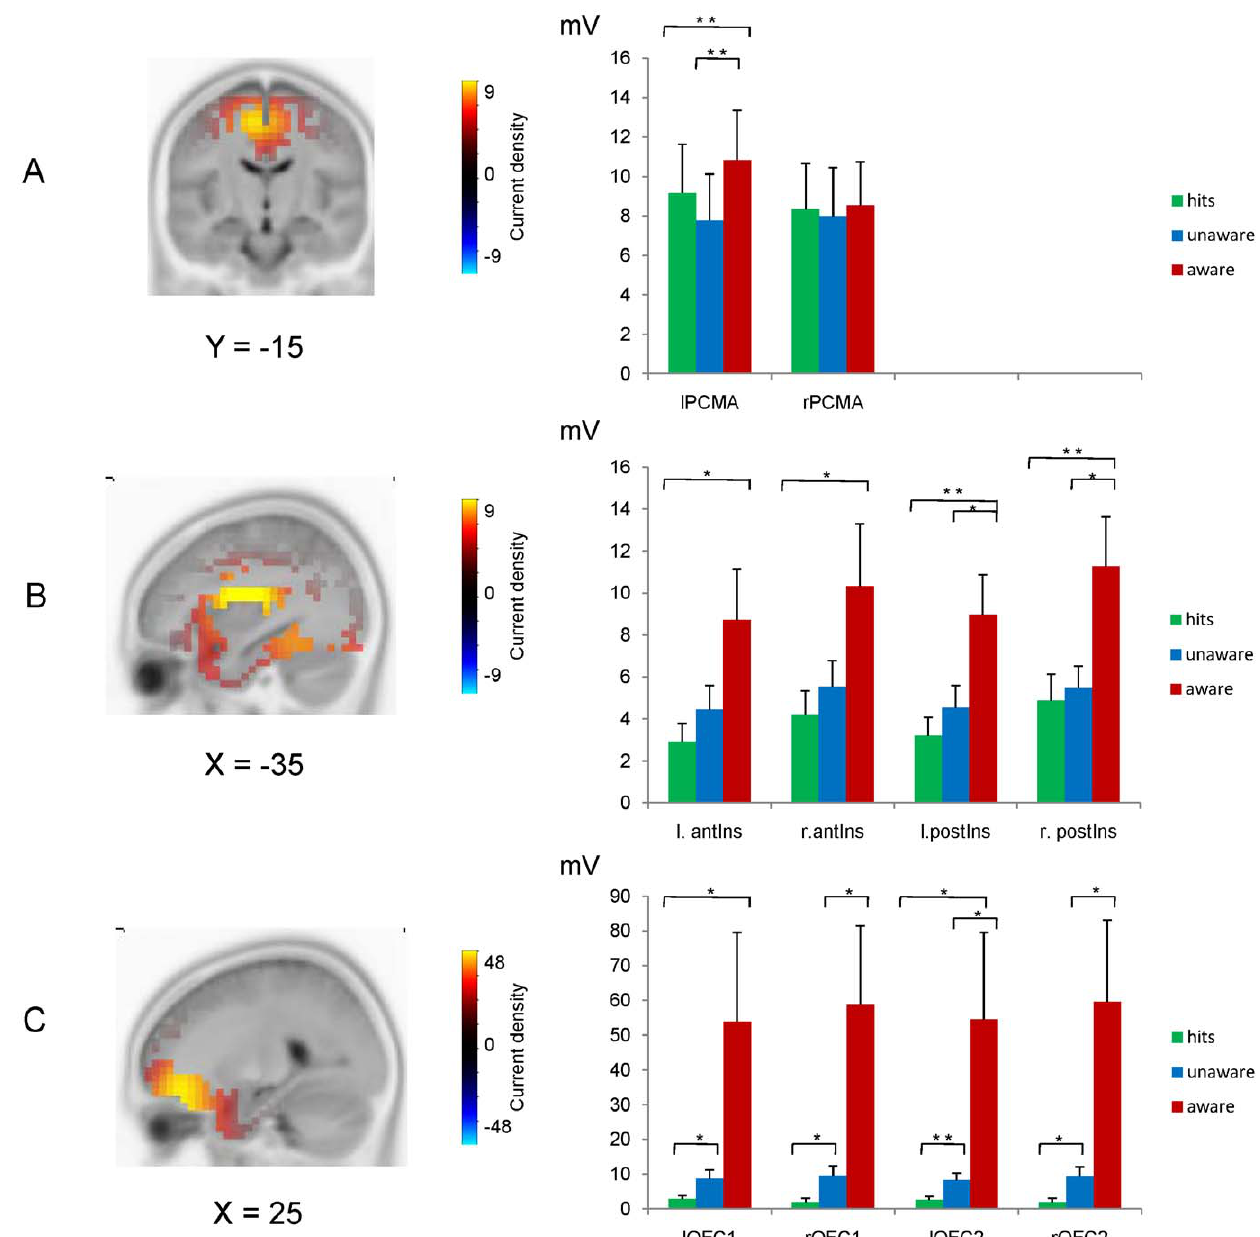
Figure 4. sLORETA sources in the PCMA, insula and OFC. (A) The sLORETA source reconstruction in bin 1 (94–114 ms; ERN/CRN time-interval) showing the PCMA ROI (B) bin 2 (312–332 ms; Pe time-interval) depicting activation of the insular cortex, and (C) displaying the OFC activation in bin 3 (660–680 ms). Corresponding graphs depict the mean amplitude in each of the four seeds per ROI for hits (green), unaware errors (blue), and aware errors (red), vertical bars corresponding to the S.E.M. * indicates a p , .05 statistical difference; **p , .01. lPCMA = left posterior cingulate motor area (x= 2 15, y= 2 25, z=45), rPCMA = right posterior cingulate motor area (x=15, y= 2 25, z=45), l.antIns = left anterior insula (x= 2 35, y= 2 10, z=15), r.antIns = right anterior insula (x=35, y= 2 10, z=15), l.postIns = left posterior insula (x= 2 30, y= 2 25, z=15), r.postIns = right posterior insula (x=30, y= 2 25, z=15), lOFC1 = left orbitofrontal cortex (x= 2 25, y=35, z= 2 25), rOFC1 = right orbitofrontal cortex (x=25, y=35, z= 2 25), lOFC2 (x= 2 20, y=35, z= 2 25), and rOFC2 (x=20, y=35, z= 2